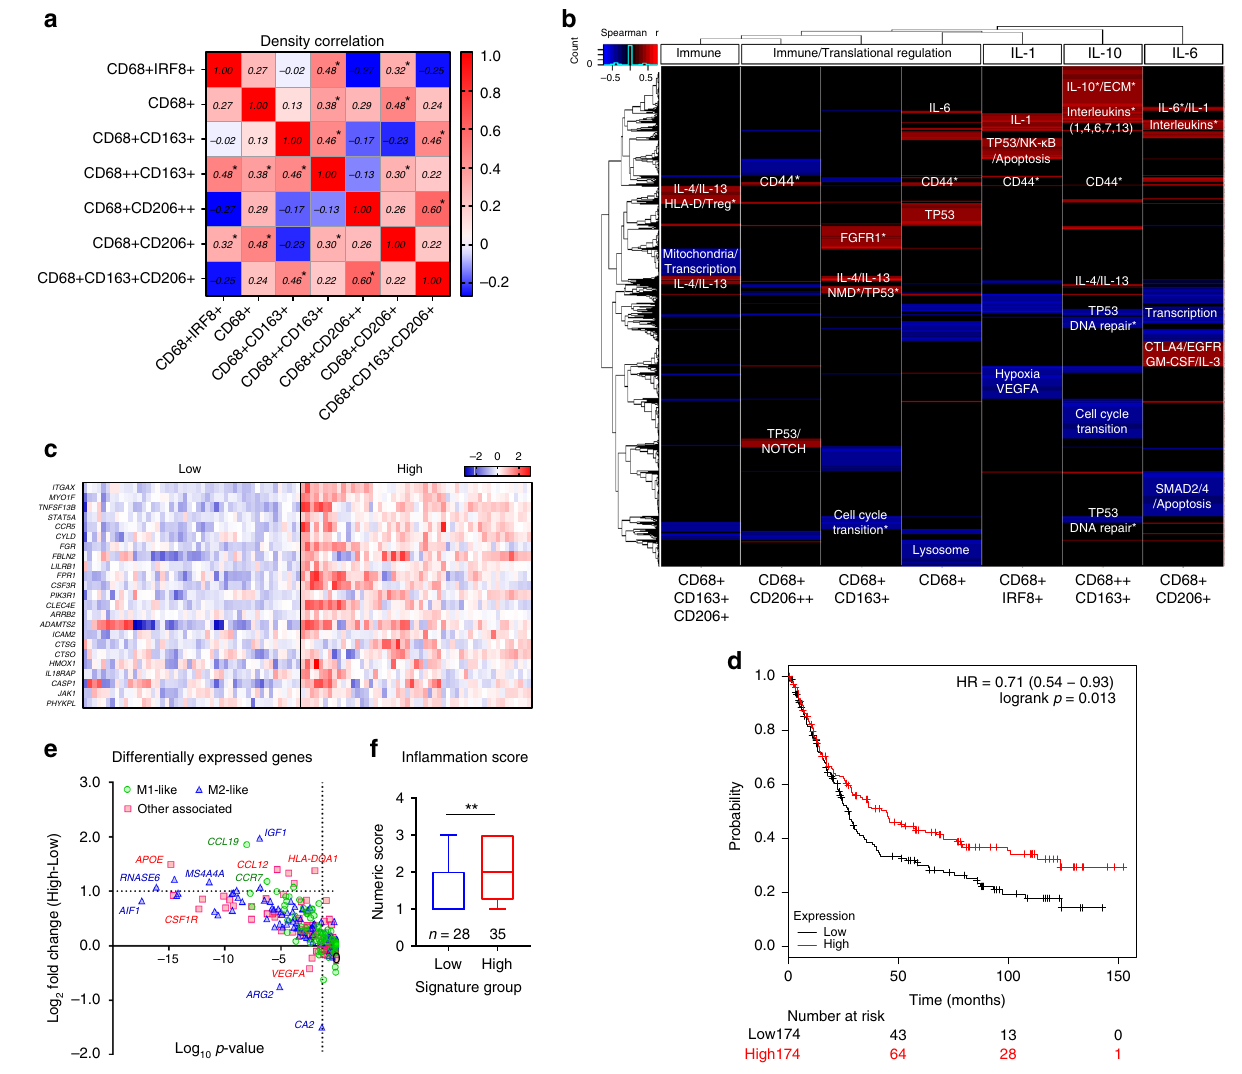
Fig. 4 High CD68 ++ CD163 + TAM density re fl ects a more in fl amed microenvironment and enhanced immune-cell in fi ltration. a Spearman correlation of TAM population densities in the tumor core. Red/white/blue: positive/no/negative correlation. * p < 0.05. b Unsupervised clustering of TAM-associated environmental signatures and associated pathways. List of genes that were signi fi cantly correlated with each TAM population density of a matched patient sample ( n = 34) were identi fi ed with the Spearman correlation. Red/black/blue: positive/no/negative correlation. *FDR < 0.05 (Benjamini-Hochberg 40 ). c Patients in the MAUGIC cohort ( n = 99) grouped using a re fi ned CD68 ++ CD163 + TAM signature (gene expression most signi fi cantly correlated with cell density, p < 0.001; Spearman correlation). Key: relative gene expression. d Validation of patient overall survival classi fi ed by the re fi ned CD68 ++ CD163 + TAM signature using KMplot 41 . Above (red) and below (black) the median expression of the gene signature. Log-rank (Mantel-Cox) test. e Differentially expressed macrophage-associated genes, and f in fl ammation scores between the high – low patient groups in the MAUGIC cohort. Box and whiskers represent mean ± 10 – 90 percentile. ** p < 0.01. Mann – Whitney U